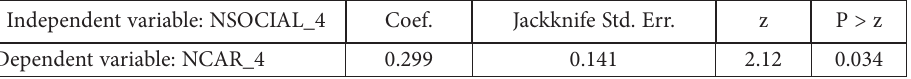
Table 10. Social transparency – shareholders’ performance association (source: own design)